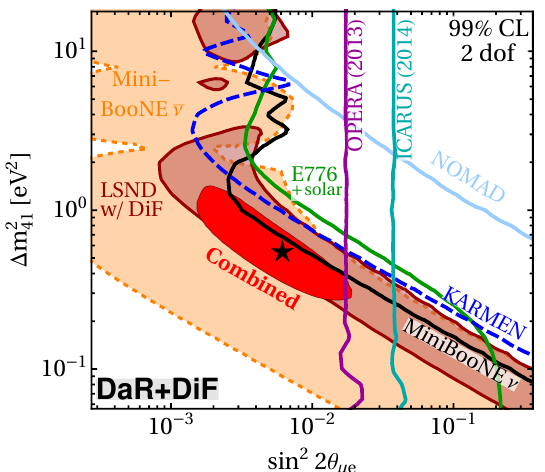
– ) ν → ( – ) ν Figure 3: Combined ( results. All the parameter space inside the coloured µ e regions is allowed at 99% CL by the two experiments that saw a positive signal: LSND and MiniBooNE. All the parameter space to the right of the coloured lines is disfavoured at 99% CL by experiments that did not see any significant excess above ) plane: see text for background. The regions are shown in the ∆ m 2 vs sin 2 ( 2 θ µ e details. Figure extracted from Ref. [ 13 ]